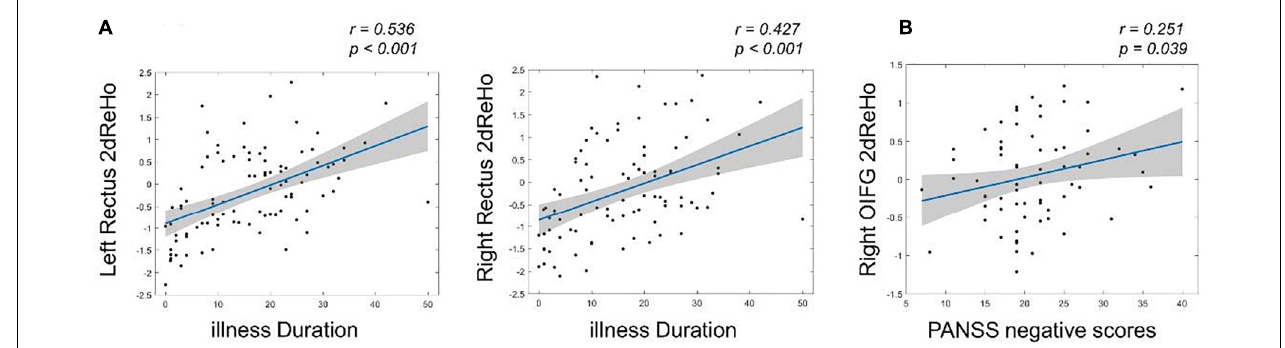
FIGURE 3 | The relationships between surface-based 2dReHo and clinical variables in patients with SZ by using Spearman rank correlation analysis. (A) The left and right rectus 2dReHo were significantly positive correlated with the illness duration (FDR corrected, p < 0.05); (B) the right OIFG 2dReHo exhibited significant positive correlation with the PANSS negative scores. OIFG, orbital inferior frontal